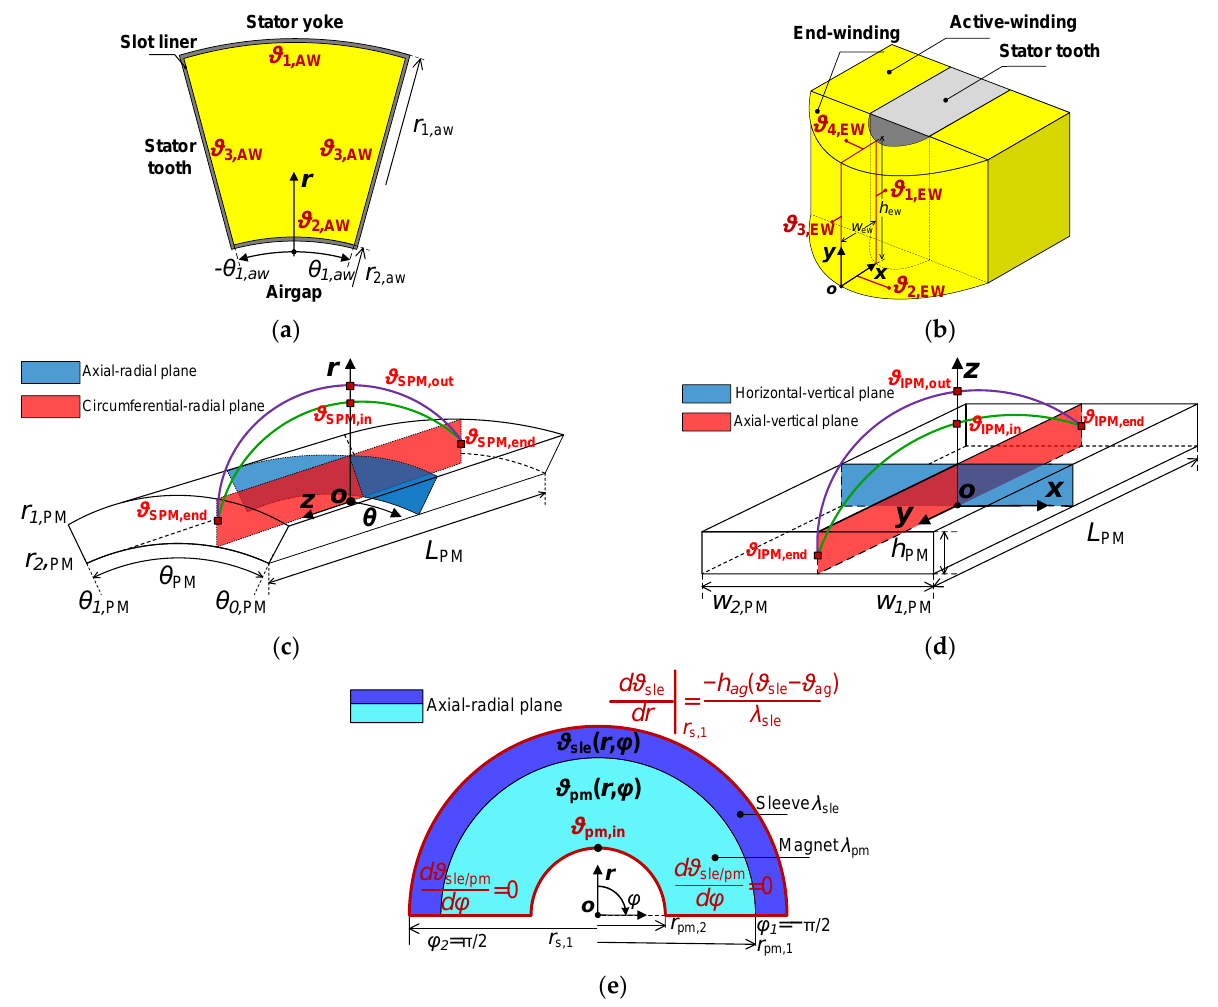
Figure 29. Analytical thermal modelling. ( a ) Active-winding [66]. ( b ) End-winding (concen-